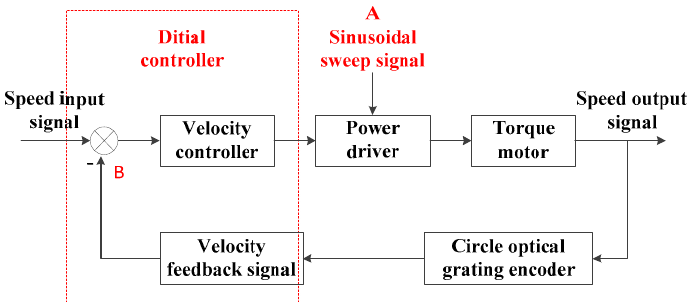
Figure 1. Control structure of the pitch axis servo turntable system.